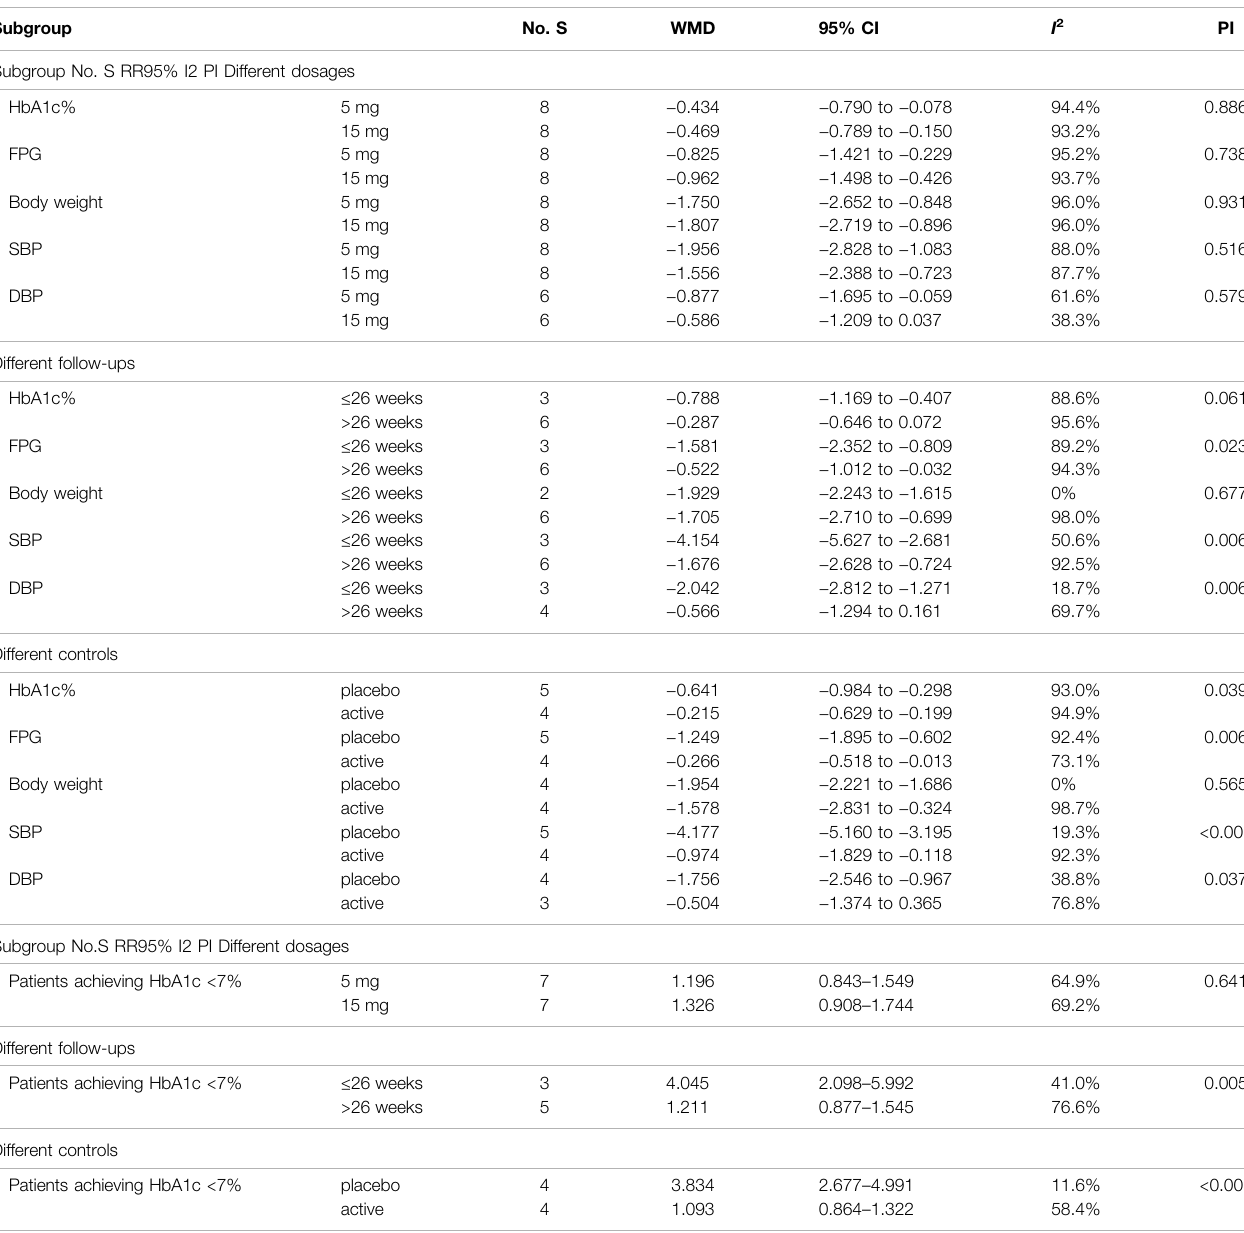
TABLE 2 | Subgroup analysis of main ef fi cacy outcomes of ertugli fl ozin vs.